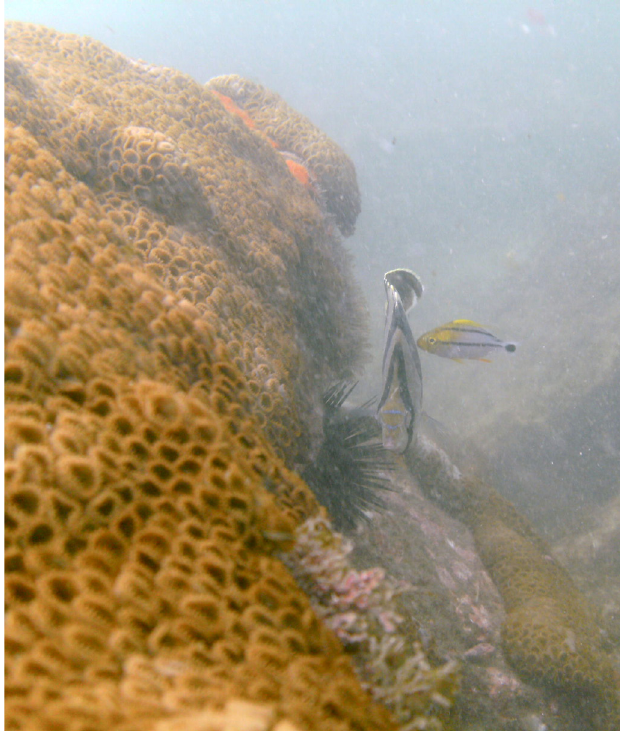
Figure 3. Epinephelus morio Acanthurus coeruleus (A) in the Currais Archipelago and (B) in the Itacolomis Island. Photos by Felippe Daros.